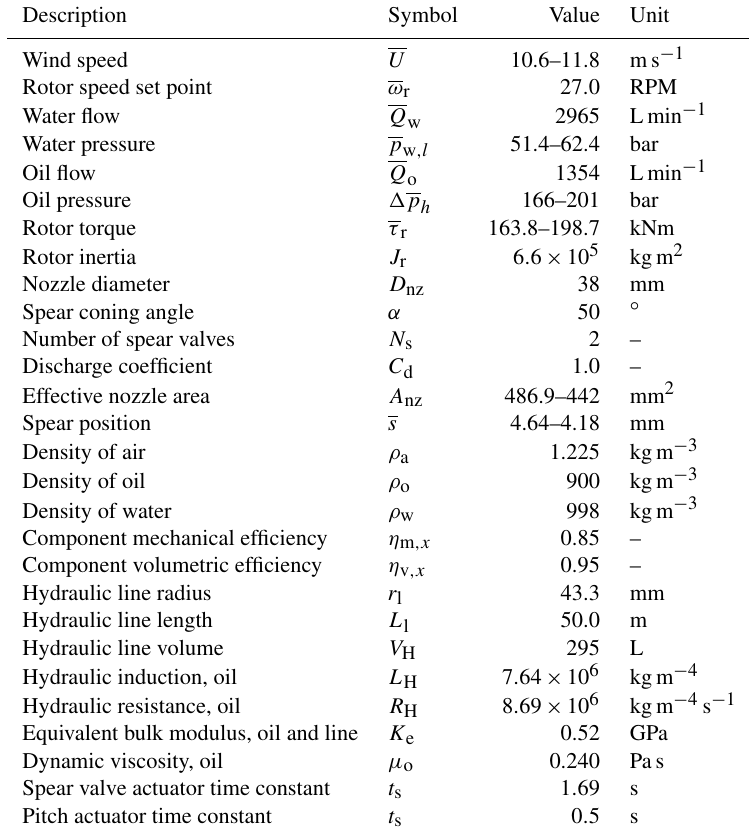
Table 2. Parameters for the linearization of the model in the near-rated operating